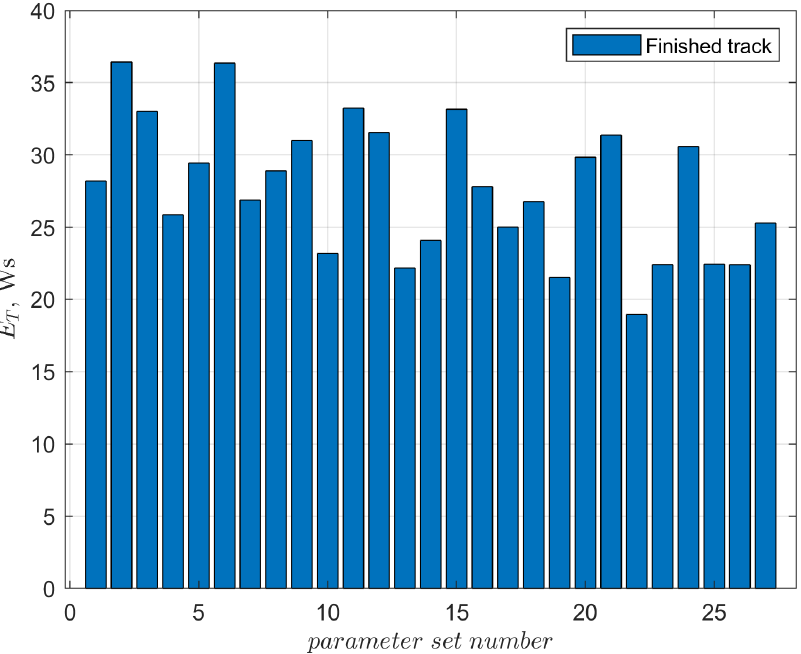
Figure 18. Energy used to complete the path for the specified parameter set number—track 2.